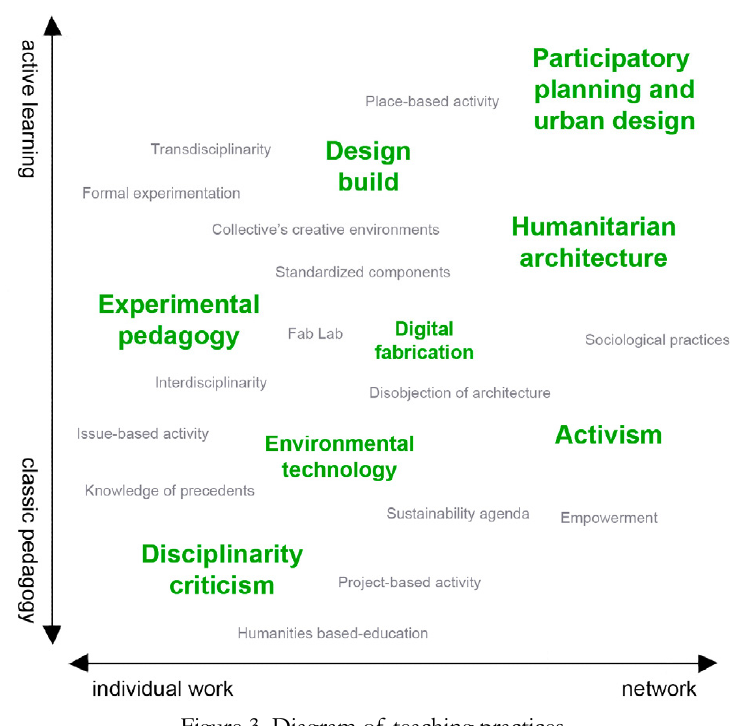
Figure 3. Diagram of teaching